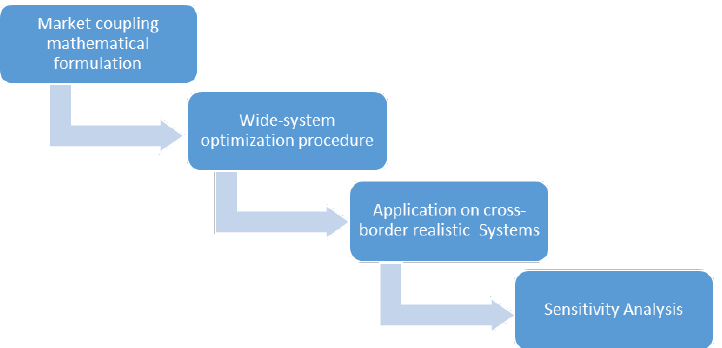
Figure 3. Basic concept of our work on electricity market coupling via NTC and FB approaches.